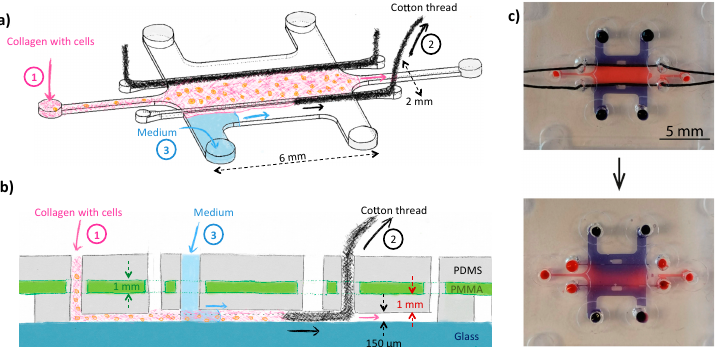
Figure 1. Schematic representation of the tumor-on-a-chip device (top ( a ) and side ( b ) views) consisting of a large cell culture chamber in which collagen supplemented with tumor cells is introduced. To confine the cell-laden hydrogel in the center of the device, removable filaments (cotton threads, here) were first introduced in the device, and pulled out of the device before gelation of the collagen (a & b). Culture medium with 21% O 2 was added in the two side channels during the experiments. The device was fabricated from PDMS and bonded to a glass substrate; the PDMS layer comprised a 175- μ m thick PMMA film to prevent O 2 from freely diffusing into the cell culture chamber so as to be able to establish gradients of O 2 in the tumor-on-a-chip model between the perfusion channels and the center of the 3D cellular model. ( c ) Pictures of the fabricated device loaded with dyes (blue: Trypan blue; red: dextran labeled with fluorescein and TAMRA) before (top) or 5 min after (bottom) removing the cotton threads. On these pictures, all reservoirs have a 1.5-mm